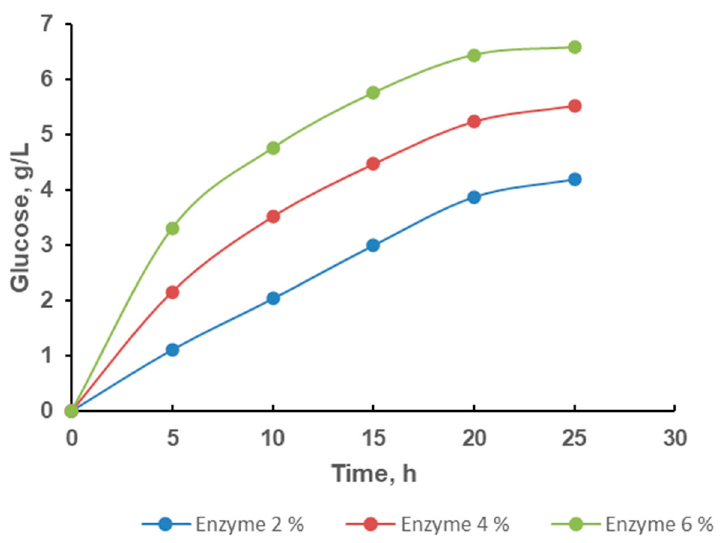
Figure 5. Effects of hydrolysis time on glucose concentration of CHPA pretreated sample.